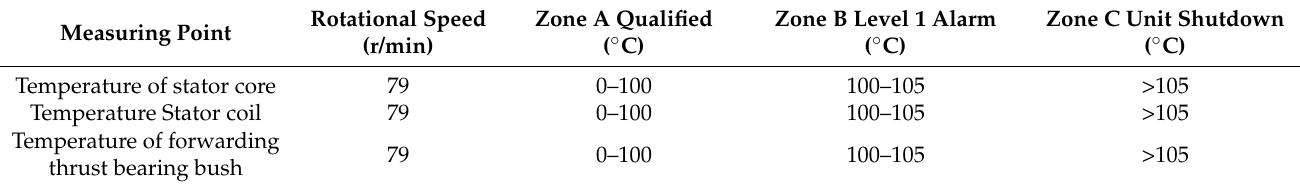
Table 8. Temperature alarm threshold of the monitoring system of hydropower